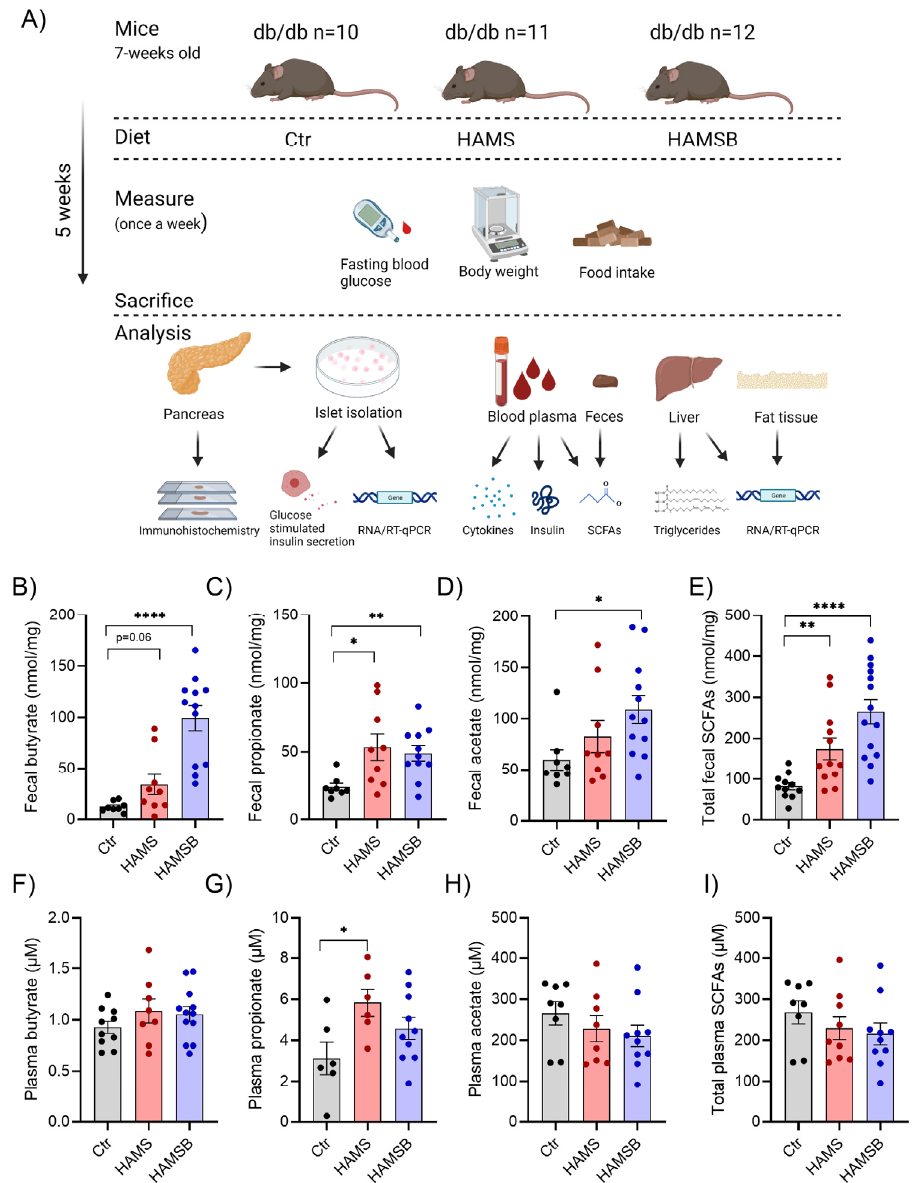
Figure 2. Experimental overview and SCFA concentrations in feces and plasma. ( A ) Db/db mice were fed either a control diet (Ctr, AIN-93G), a diet supplemented with 15% HAMS, or a diet supplemented with 15% HAMSB for 5 weeks. Blood glucose, body weight and food intake were measured weekly. After 5 weeks, the mice were sacrificed, and tissues were collected for analyses. SCFA concentrations were measured in the feces ( B – E ) and plasma ( F – I ) of db/db mice at the end of the study. Bars show the mean ± SEM. * p < 0.05, ** p < 0.01 and **** p <